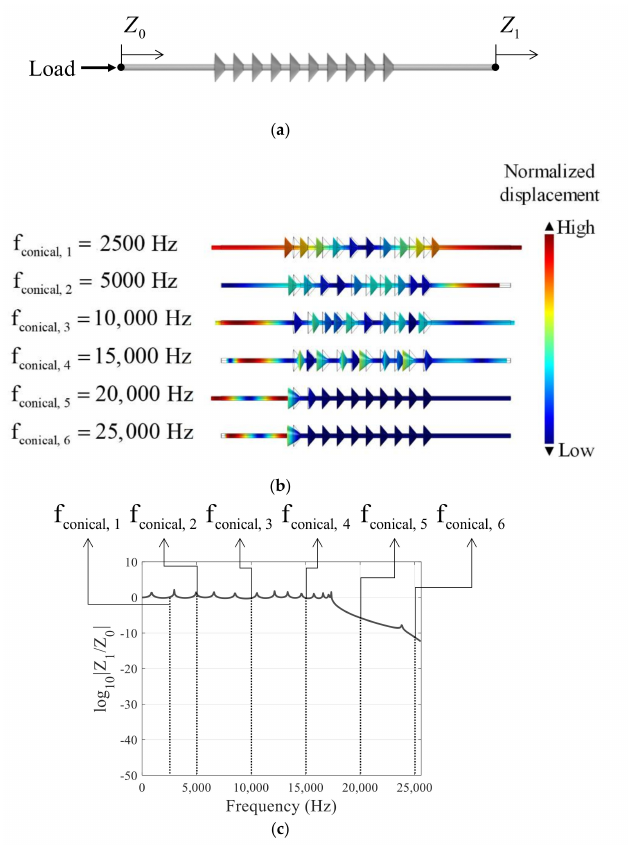
Figure 7. ( a ) Model of conical metamaterials, ( b ) displacement at certain frequency and ( c ) the frequency responses ( r p = 0.03 m, h p = 0.02 m, s = 0.02 m, n =